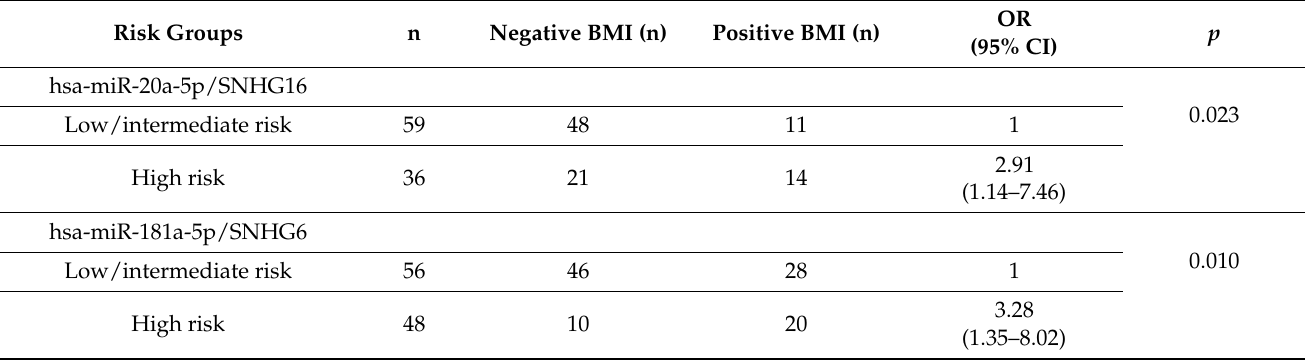
Table 3. The association between the risk groups considering the plasma levels of each ceRNA pair and the presence of bone marrow involvement in NHL patients.